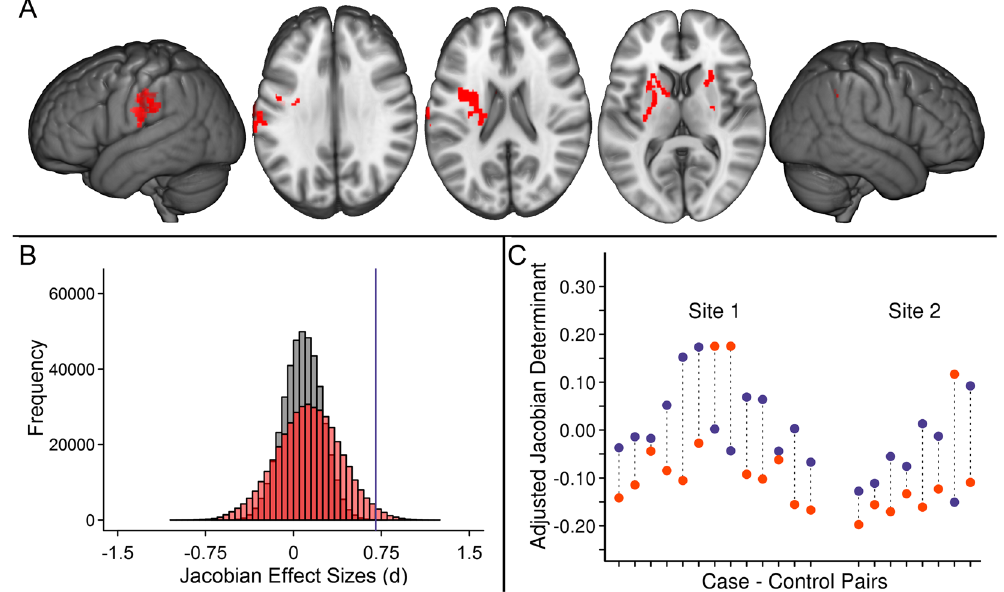
Figure 1. ( A ) Children with reading disability had brain images that required expansion to fit to a study- specific template compared to brain size and research site matched controls from the Dyslexia Data Consortium multi-site dataset (www.dyslexiadata.org). Parietal cortex, corona radiata, and internal capsule exhibited case- control differences were observed, in particular. Non-parametric permutation testing was used to correct for multiple comparisons ( p < 0.05, red). ( B ) Histograms show the larger Cohen’s d effect sizes for the case-control design (red) compared to a typical unpaired group difference design (gray) across the 480,730 voxels within an inclusive gray and white matter mask. ( C ) The reason for statistical benefit of the case-control design is demonstrated by the relatively consistent left SII/anterior supramarginal gyrus (shown in A ) differences in cases (orange) compared to matched controls (blue), despite the high morphologic variance within and across sites. Adjusted Jacobian determinant refers to the Jacobian or volumetric displacement values after correcting for brain size and research site-based propensity scores 58